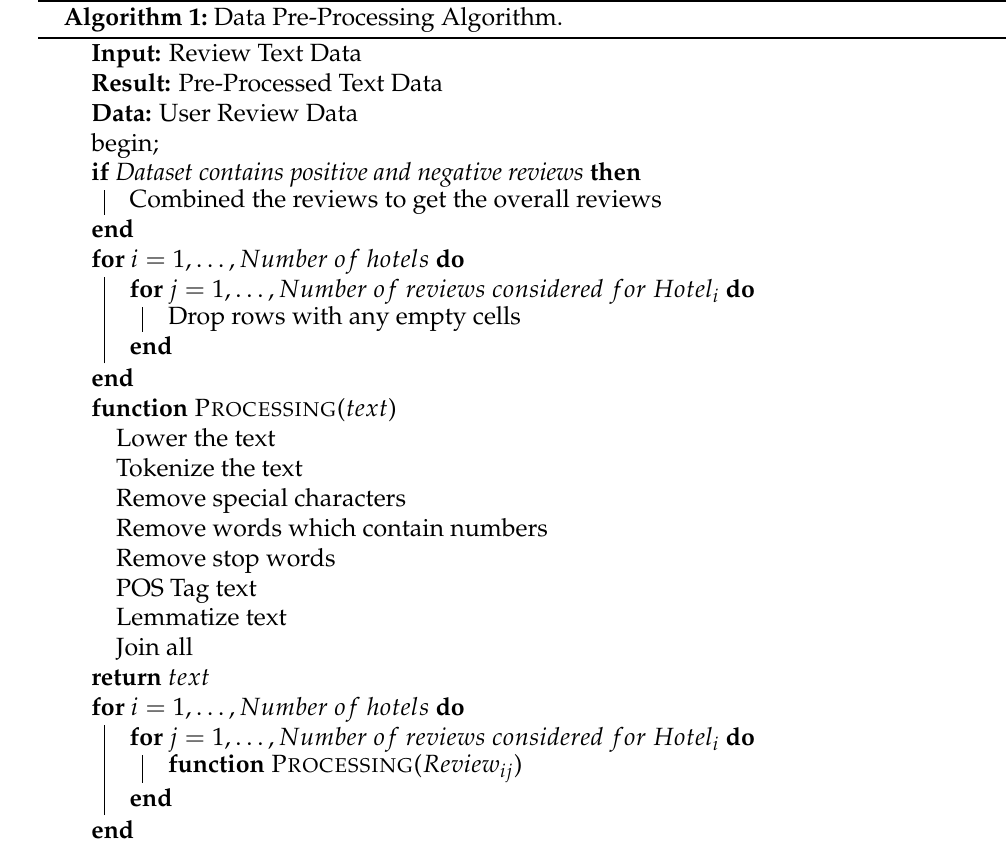
Algorithm 1: Data Pre-Processing